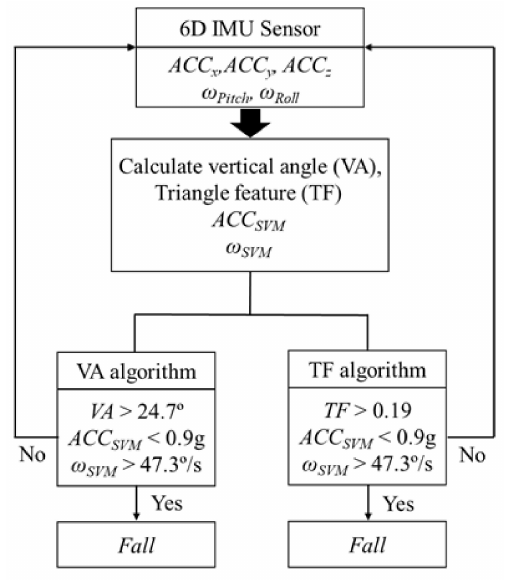
Figure 3. Pre-impact fall detection algorithm (Vertical angle (VA) and Triangle feature (TF)